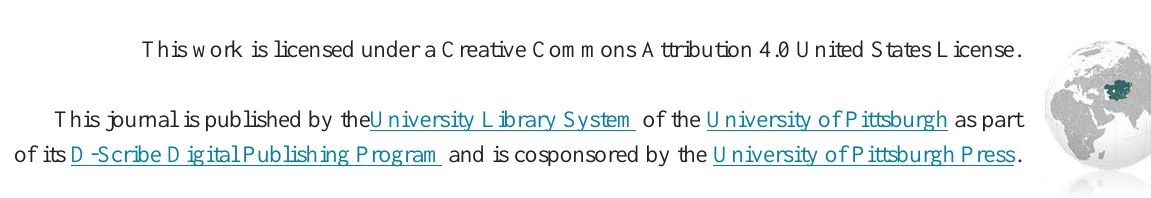
Table 1. Proportion of respondents showing positive attitudes, MICS 2000,